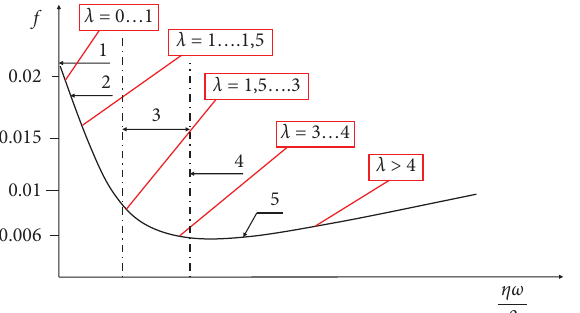
Figure 6: Te friction coefcient ( f ) and lubrication mode ( λ ) according to the Hersey–Stribeck diagram. 1: dry, 2: boundary, 3: mixed; 4: elastohydrodynamic; 5: hydrodynamic lubrication modes. Table 3: Antifriction and lubrication characteristics of transmission oils for hypoid gears. Parameter